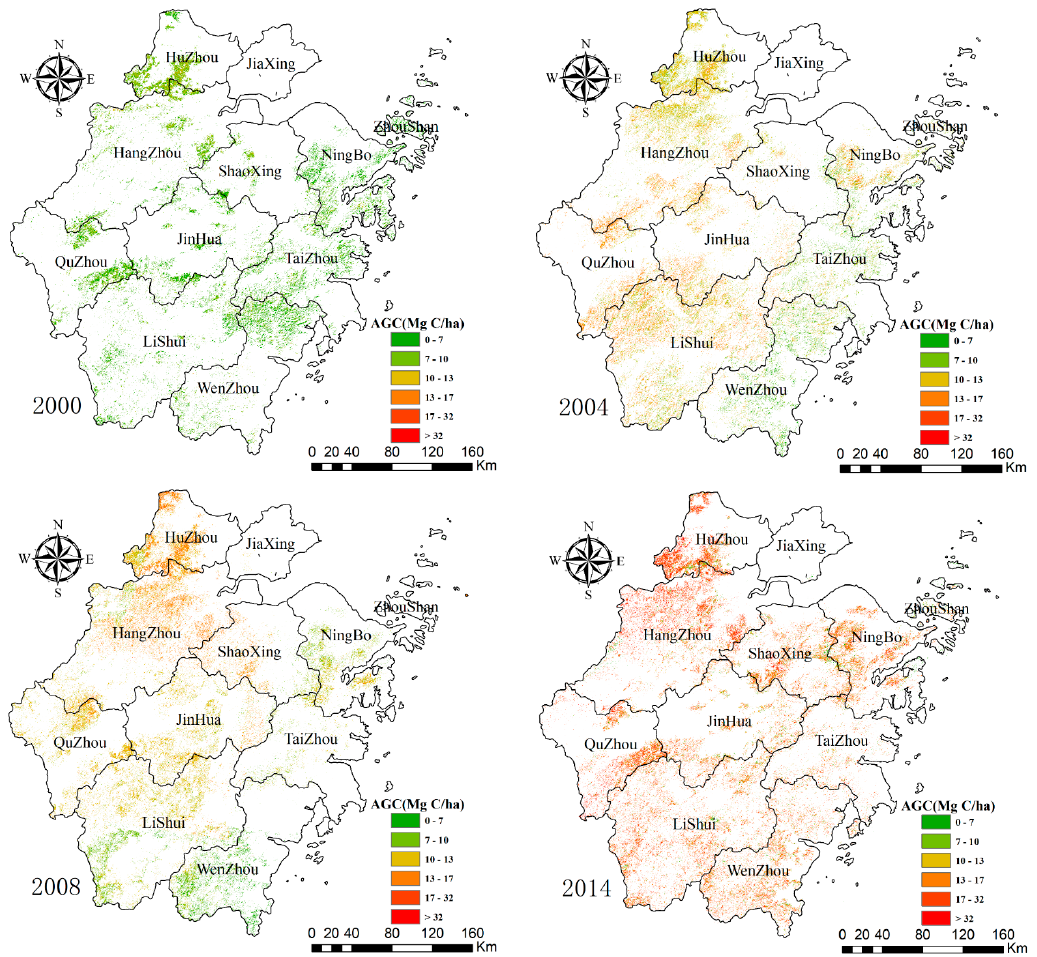
Figure 4. The AGC spatial Distribution map of bamboo forest in Zhejiang Province in different years.